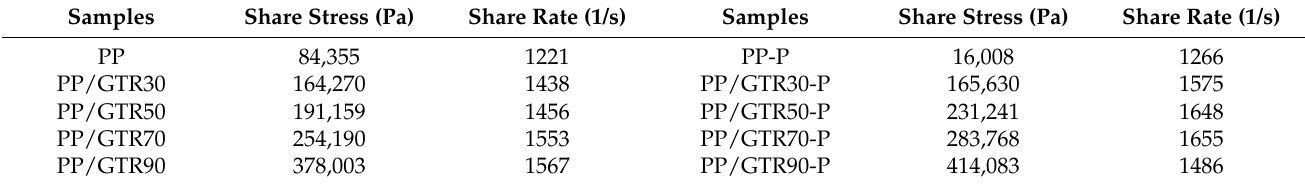
Figure 7. Influence of GTR content on the apparent viscosity of PP/GTR compounds. Table 2. Rheological parameters of PP/GTR compounds recorded during injection molding .